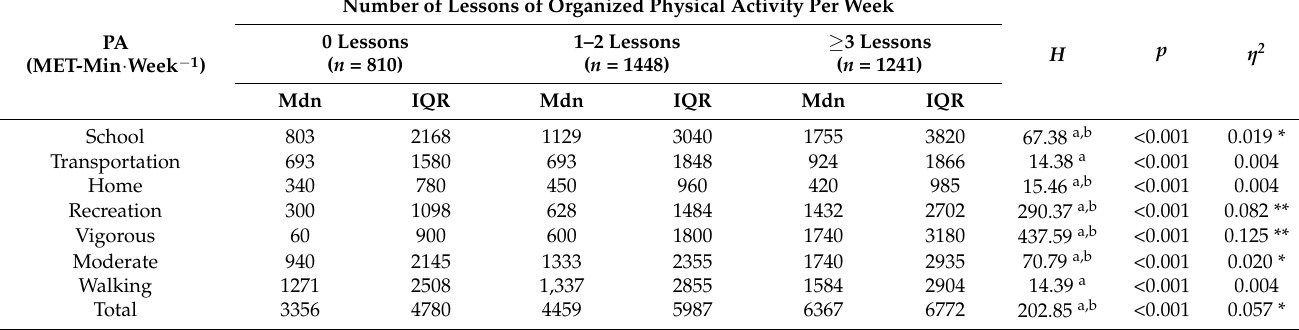
Table 3. Weekly physical activity (MET-min · week − 1 ) among adolescents according to participation in organized physical activity, assessed using the